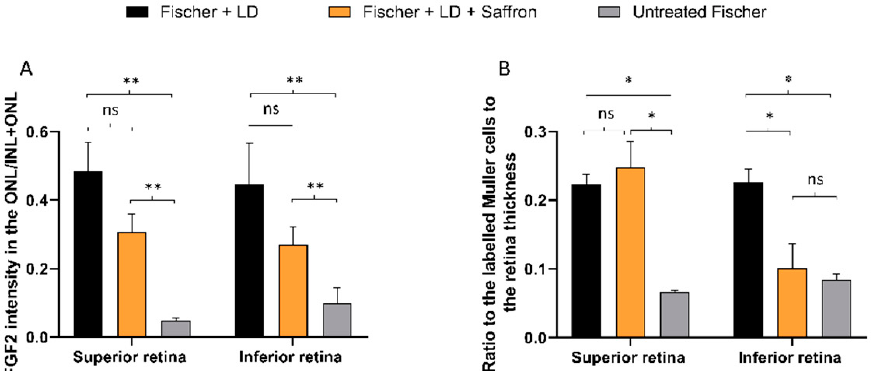
Figure 5. Photoreceptors rows. Count of photoreceptor rows in the superior and inferior retina in control and treated and untreated light damage (LD) Fischer rats (rats n = 6 each group; ± SEM; Statistical tests: TWO way ANOVA followed by Dunnett’s test. Fischer + LDvsFischer + LD + Saffron p < 0.001; Fischer + LDvsUntreatedFischer p < 0.001).